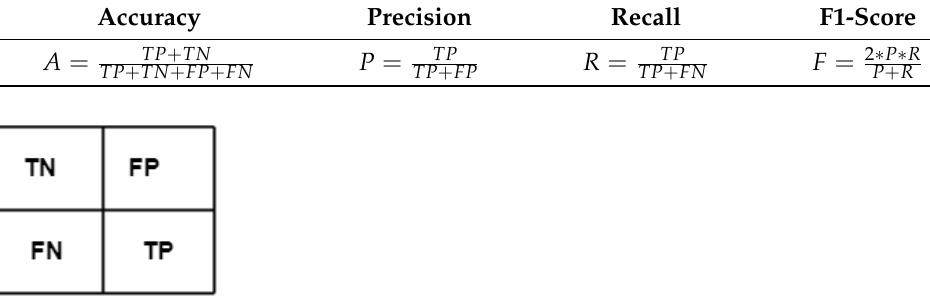
Figure 6. The Confusion